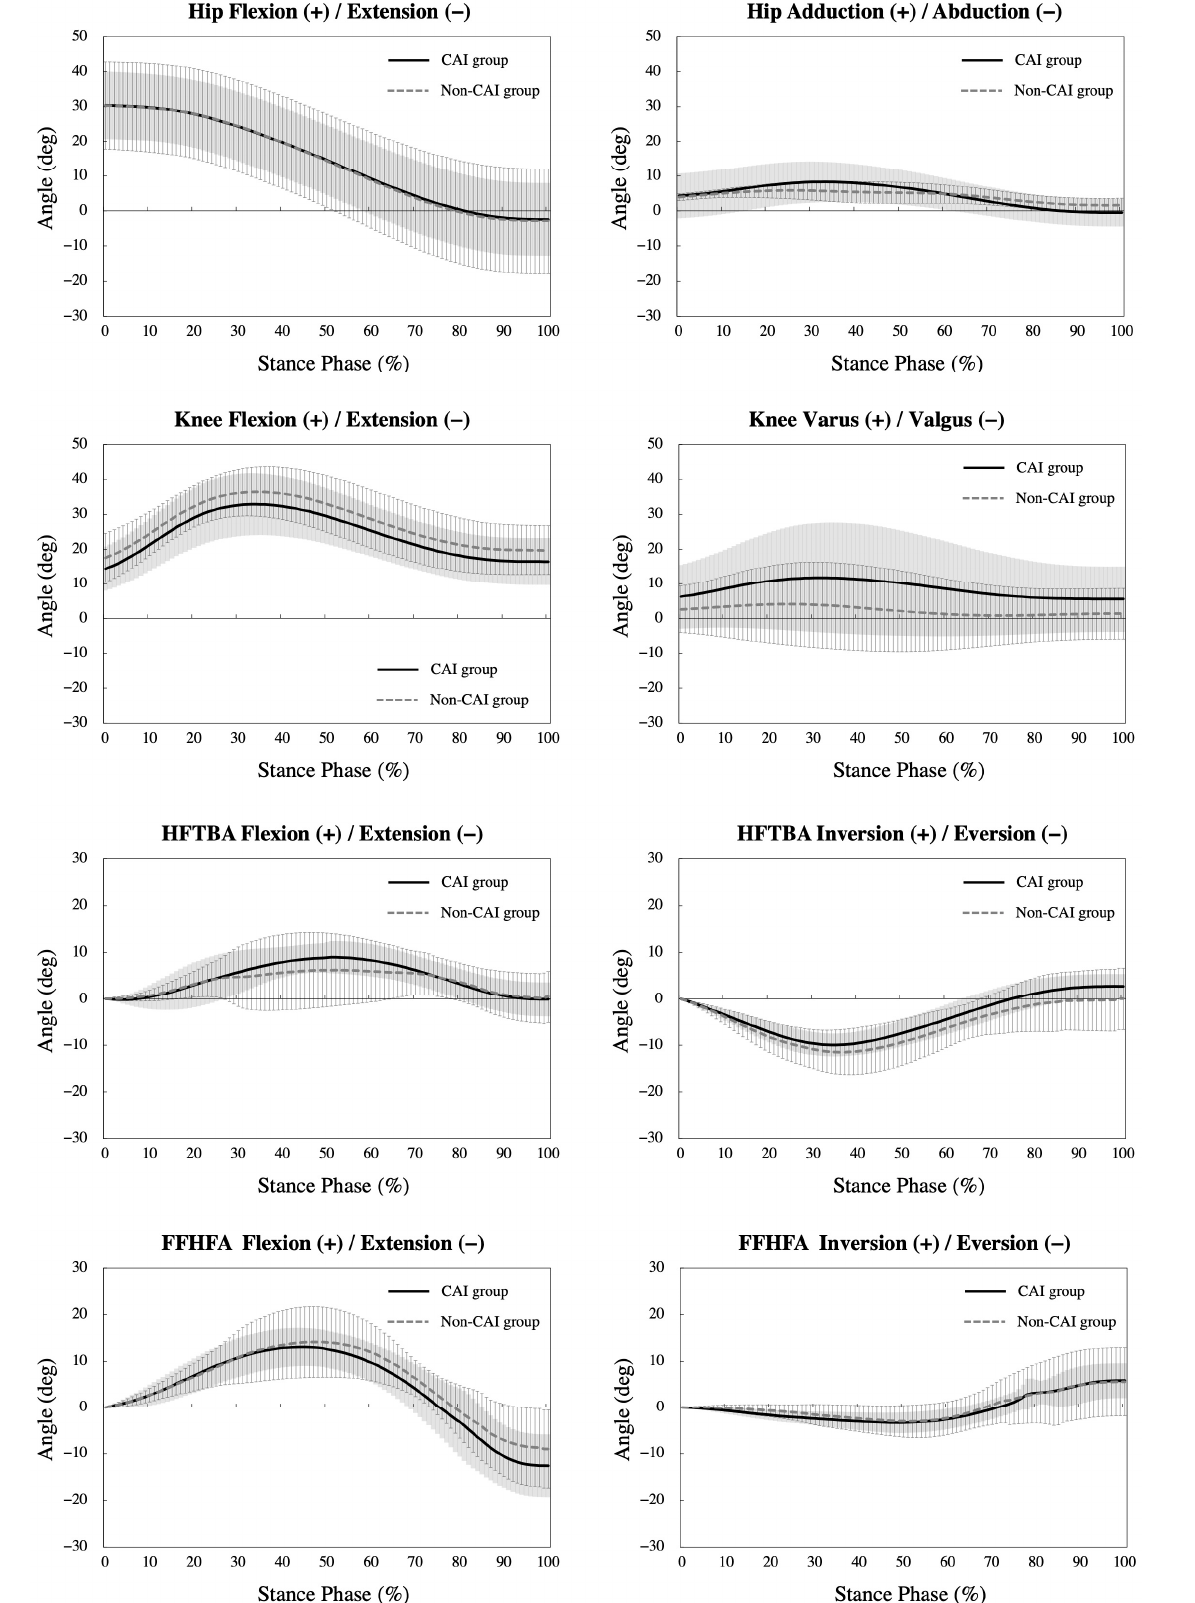
Figure 2. Time-series data of the hip, knee, and foot angles of the CAI and non-CAI groups during the stance phase of